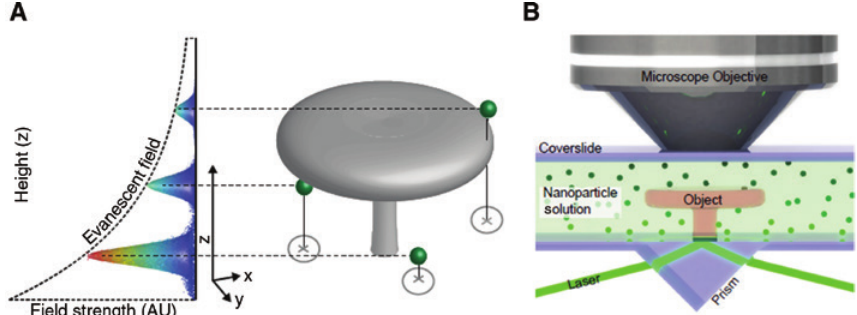
Figure 1: Principle of the PBM